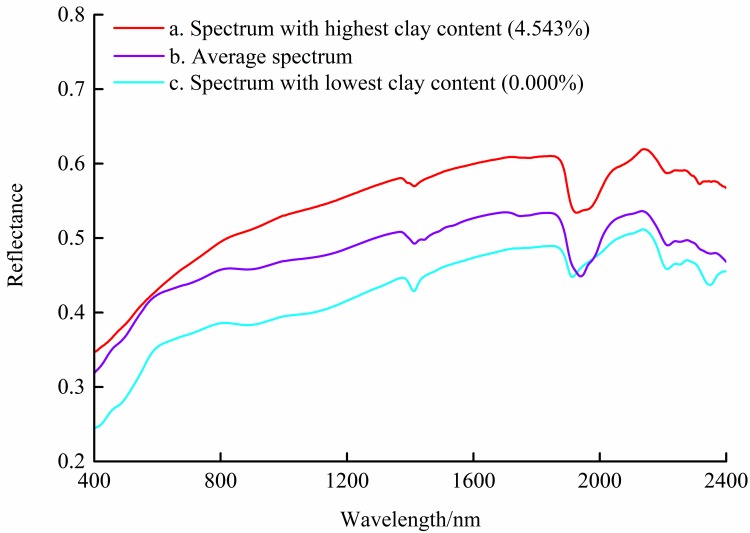
Spectral reflectance of soils with different clay contents from the Ebinur Lake basin, China.Note: spectral curve (a) denotes the soil sample with 4.543% clay content, 24.172 g kg-1 SOM, 68.547 g kg-1 Na+, and 6.044 g kg-1 Ca2+; spectral curve (c) denotes the soil sample with 0.000% clay content, 25.340 g kg-1 SOM, 3.088 g kg-1 Na+, and 2.808 g kg-1 Ca2+.